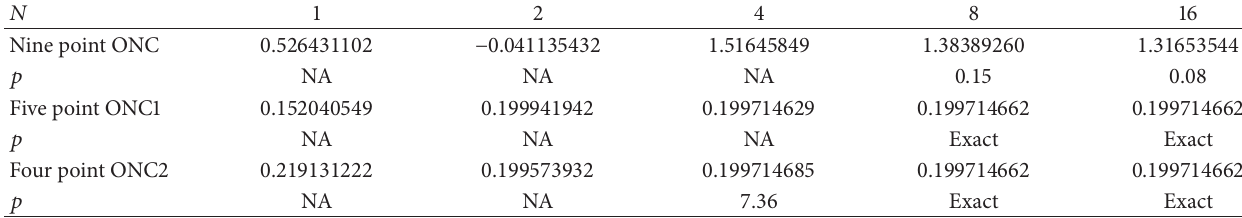
3 𝑒 −2𝑥 sin (4𝑥)𝑑𝑥 0